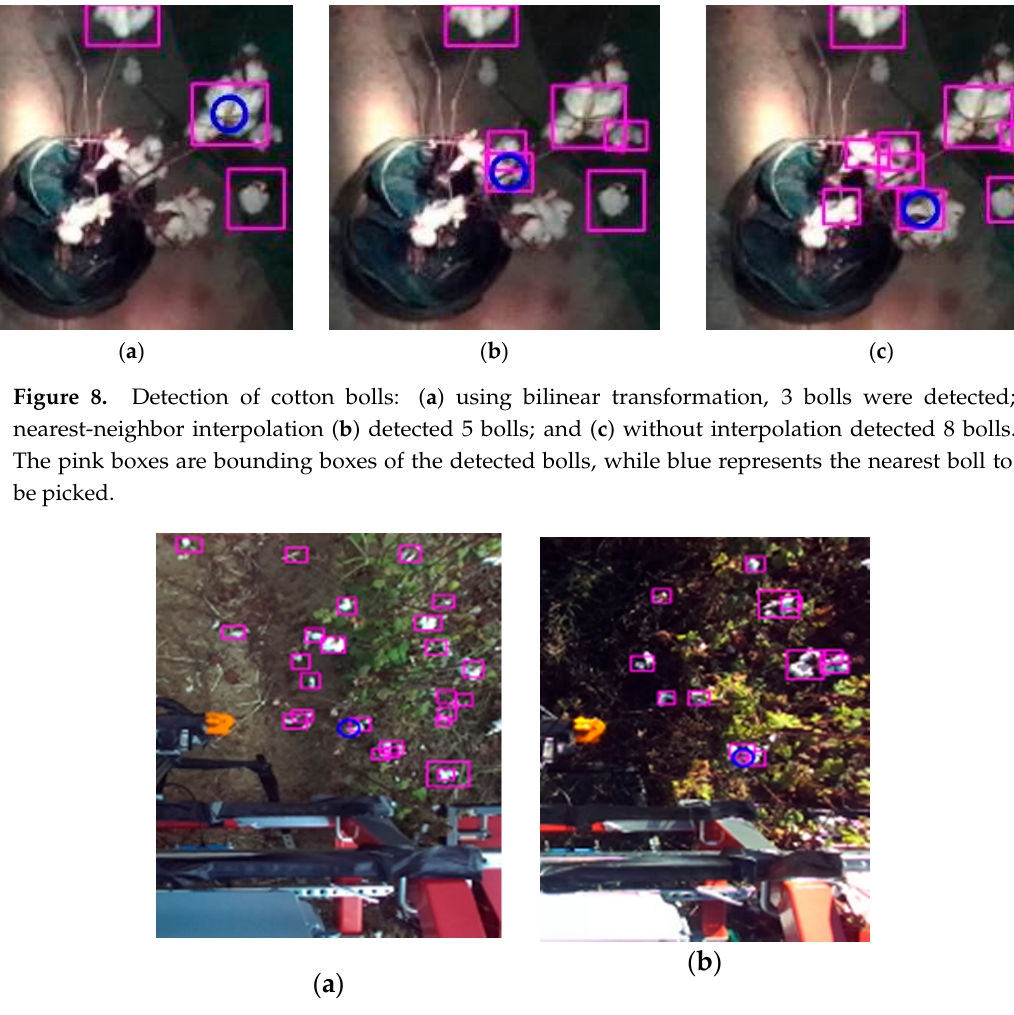
Figure 9. Boll detection using tiny YOLOv3 and ZED camera. ( a ): cloudy day. ( b ): sunny day.